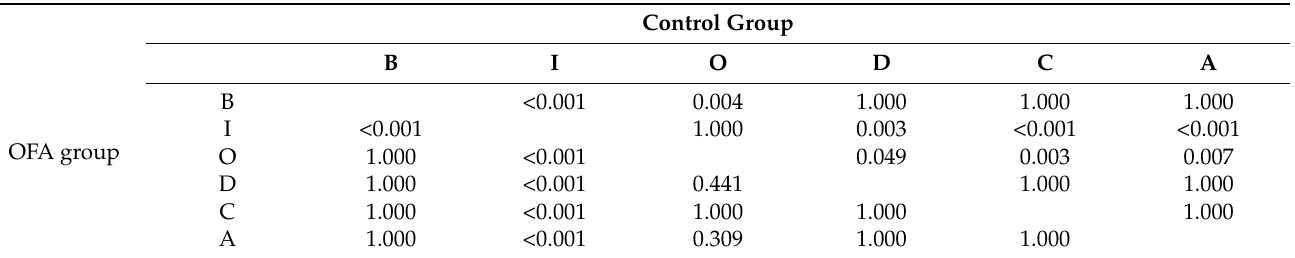
Table 5. Dunn–Bonferroni test results of SCA changes at the consecutive time points in the control and OFA groups ( p